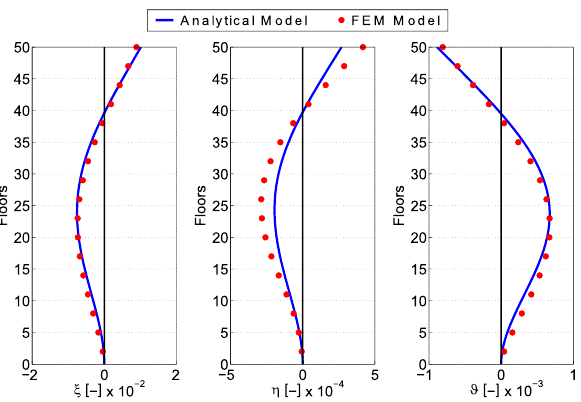
Figure 9: Normalized eigenvector components of the 6th mode shape